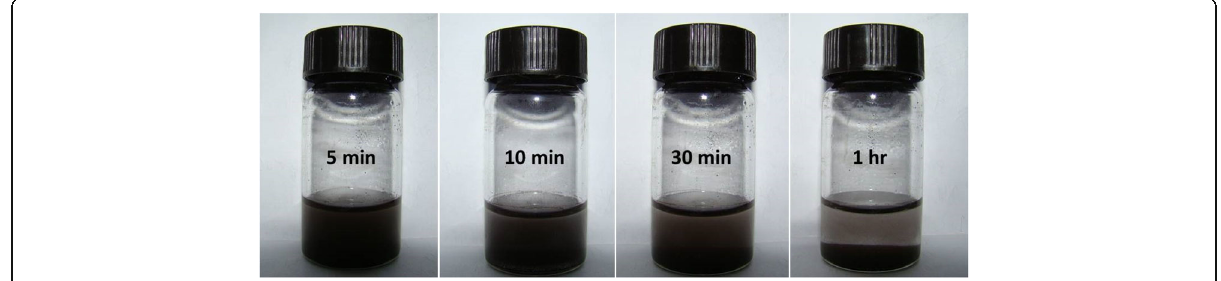
Fig. 6 Solubility of PEG-CoFe 2 O 4 nanoparticles in deionized water at different intervals (5, 10, 30, and 60 min) of